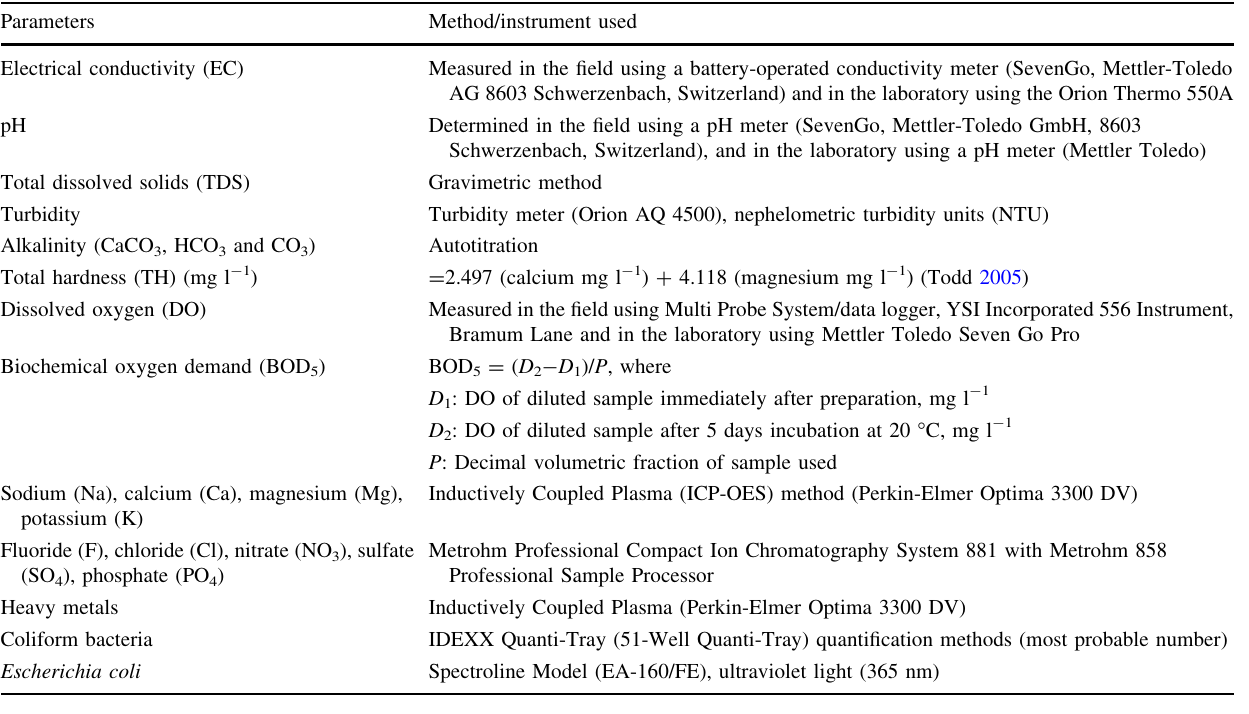
are compared with standard limits recommended by Omani Table 1 Determination of physico-chemical water quality parameters by different methods/instruments